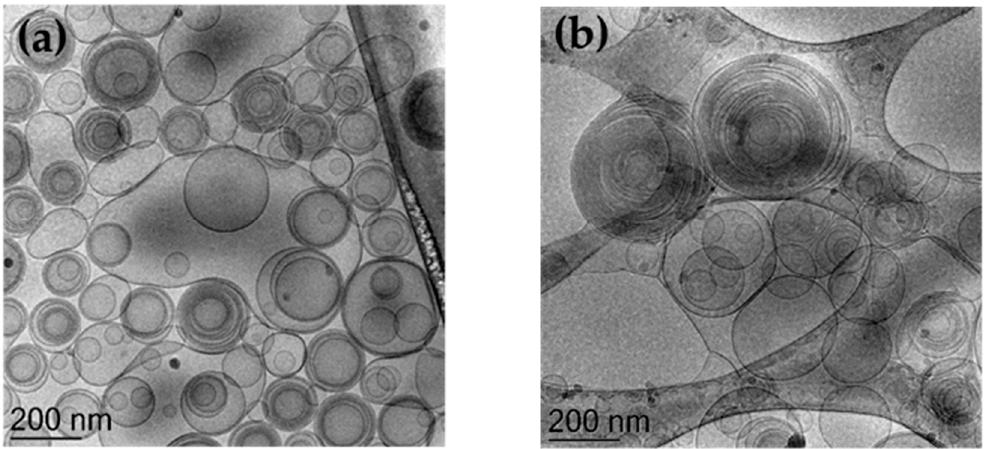
Figure 2. Cryo-transmission electron microscopy images (Cryo-TEM) of ETHO 0.9 ( a ) and ETHO-CoQ10 ( b ). Bar corresponds to 200 nm.